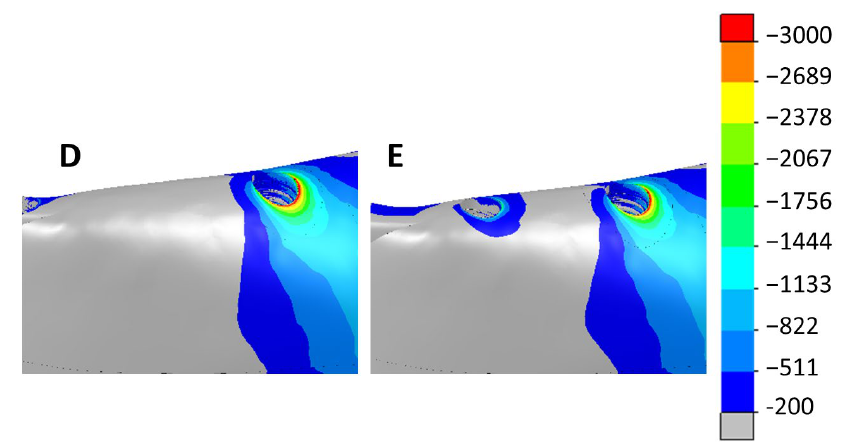
Figure 11. Distribution of the max. principal strain in scenarios with the two posterior implants distally to the foramina. Left—4 implants (D). Right—6 implants (E).